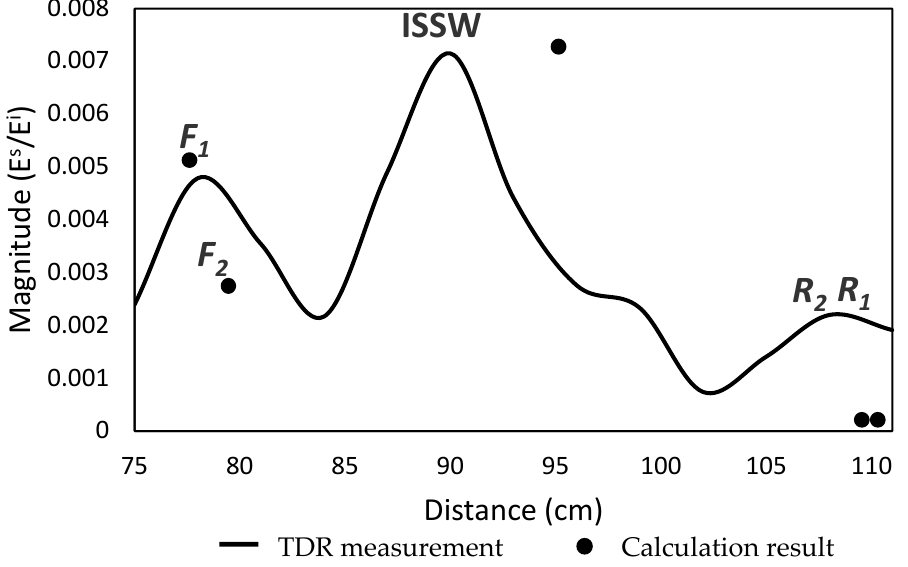
Figure 9. Time-domain response of the backscattered wave from LCS 3.